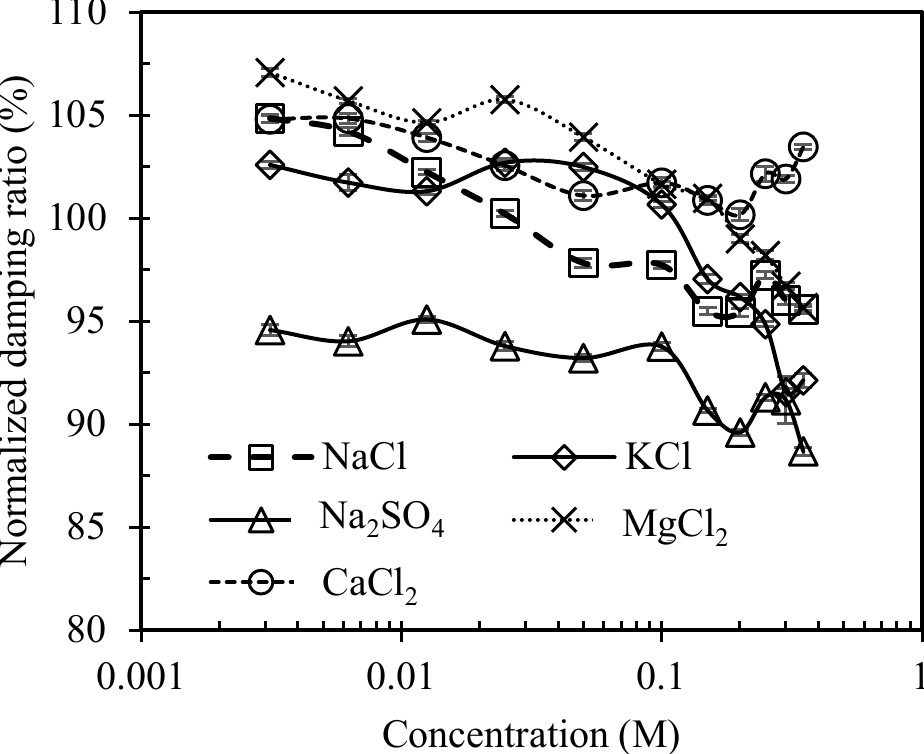
Figure 6. Normalized damping ratio (i.e., relative to that of RO water shown as red dashed line) as a function of the salt concentration.